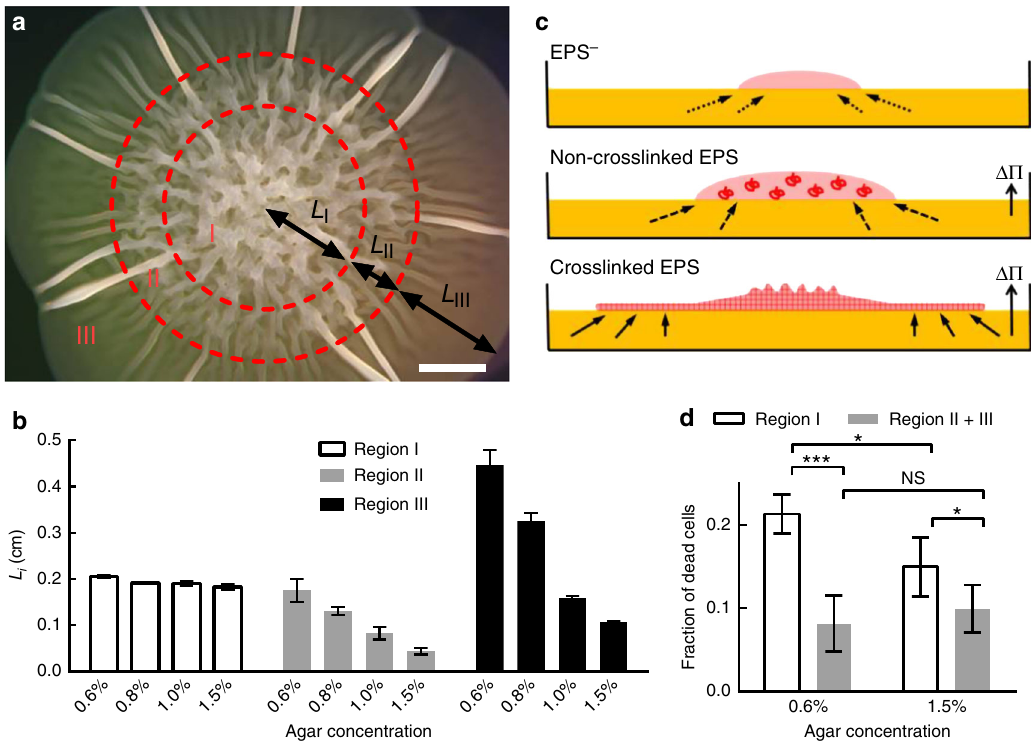
Fig. 2 V. cholerae colony bio fi lms display distinct spatially patterned regions that depend on osmotic pressure. a Representative 2-day-old Rg_M colony grown on LB medium containing 0.6% agar imaged by stereomicroscopy. Three regions can be identi fi ed (denoted I, II, and III). L i denotes the length scale of each reproducibly identi fi able region. Scale bar : 0.2 cm. b Quantitation of L i as a function of agar concentration. c Schematic representation of the proposed colony expansion mechanism for the EPS − ( top ) strain, a strain containing non-crosslinked EPS ( middle ), and a strain containing crosslinked EPS ( bottom ). Pink denotes the bacterial colony (and matrix if present). Yellow denotes the solid surface, which contains nutrients. The red coils ( middle ) denote non-crosslinked matrix polymers. ΔΠ denotes the osmotic pressure difference across the interface between the colony and the solid surface. The red mesh ( bottom ) depicts crosslinked matrix that forms a hydrogel network. Arrows with dotted lines denote nutrient uptake by diffusion ( top ); solid arrows denote nutrient transport due to the osmotic pressure difference ( bottom ), and arrows with dashed lines denote the intermediate case ( middle ). d Region I is the nutrient-limited zone in which higher cell death occurs compared to regions II and III. Paired t -tests were performed in d within the groups and unpaired t -tests with Welch ’ s correction were performed between the groups. NS denotes not signi fi cant; *denotes P < 0.05, and ***denotes P < 0.001. All error bars correspond to standard deviations with n =